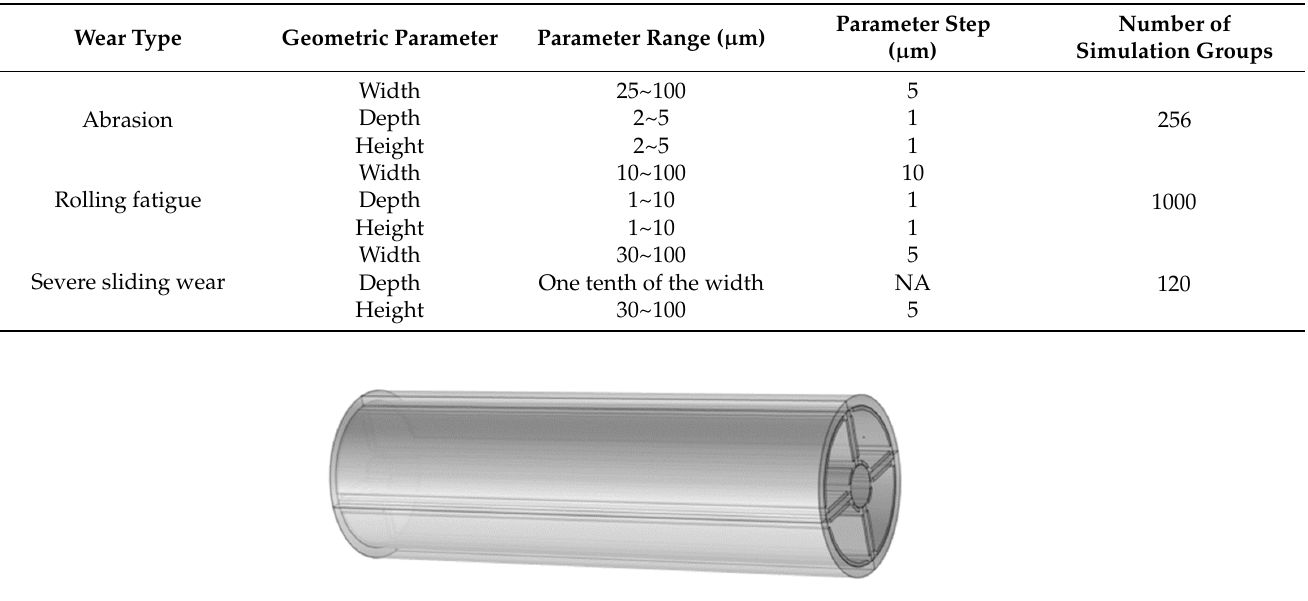
Figure 10. Simulation model of capacitive sensor.